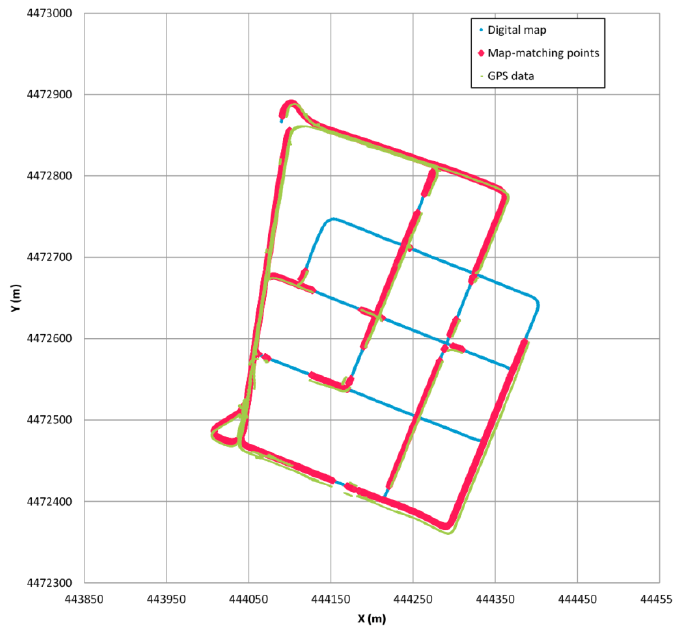
Figure 5. Example of the map-matching algorithm performance.